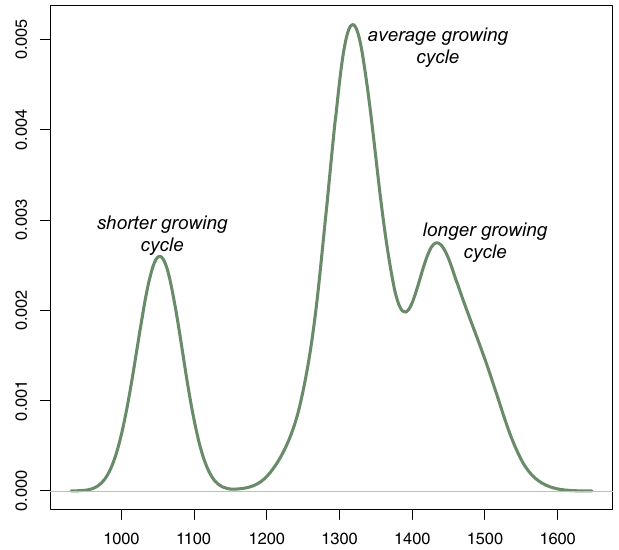
Fig. 1 Probability density function of the thermal demand to reach anthesis. Data from the 191 accessions 23